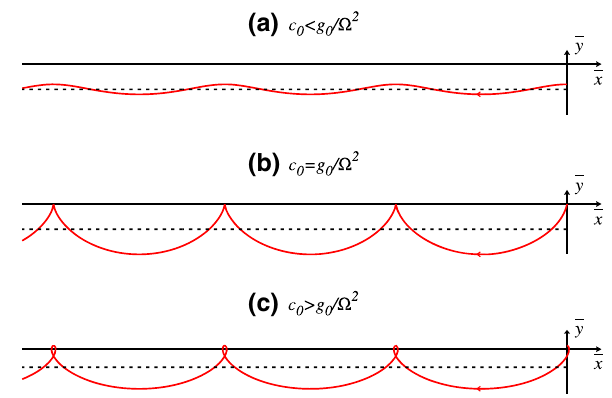
, while the blue Fig. 9 Three types for charged test particles in the weak gravitational min field of magnetized quantum-corrected Schwarzschild black holes: a no curls, b cusps, c